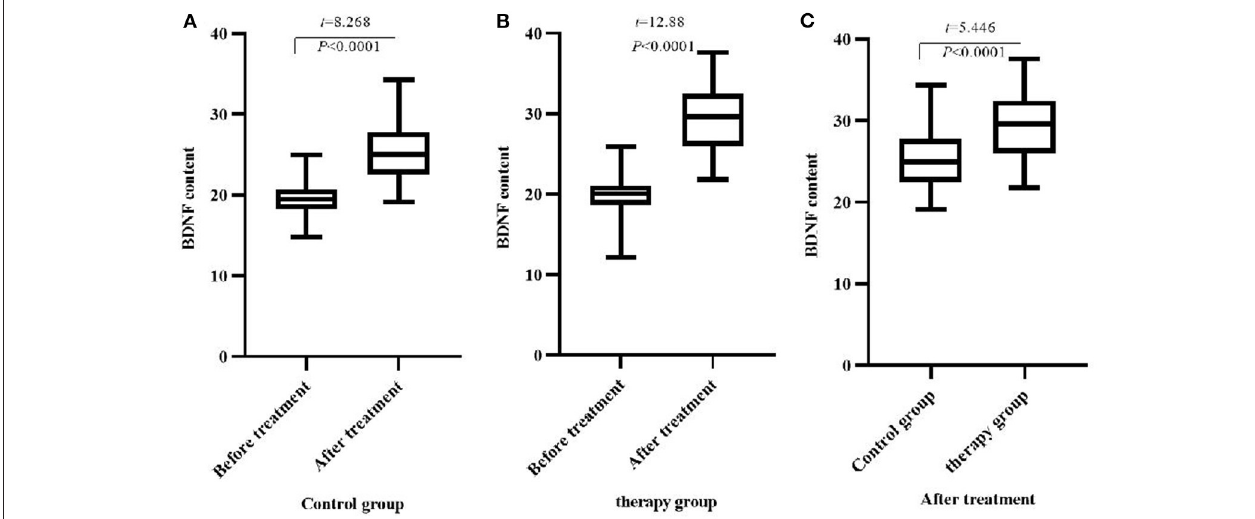
FIGURE 4 | Comparison of BDNF content before and after treatment between the two groups (M ± SD, ng/mL). (A) Comparison of BDNF content in the control group before and after treatment; (B) Comparison of BDNF content in the therapy group before and after treatment; (C) Comparison of BDNF content in the two groups after